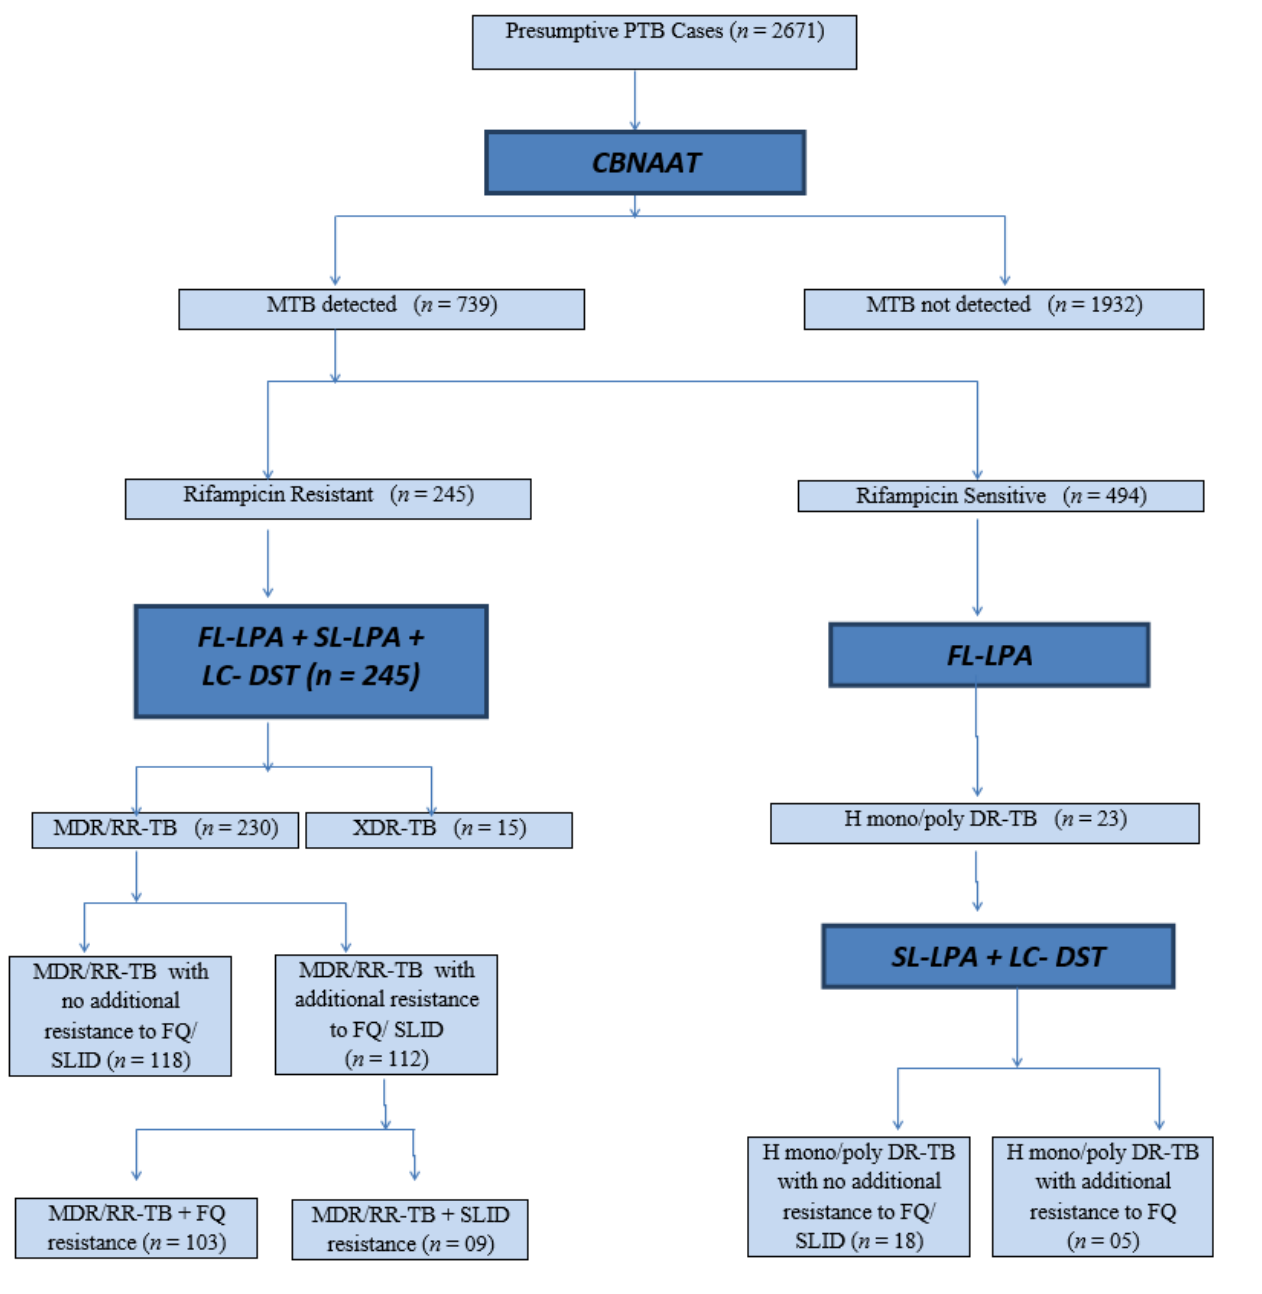
Figure 1. Flowchart—drug ‐ resistant TB diagnosis.